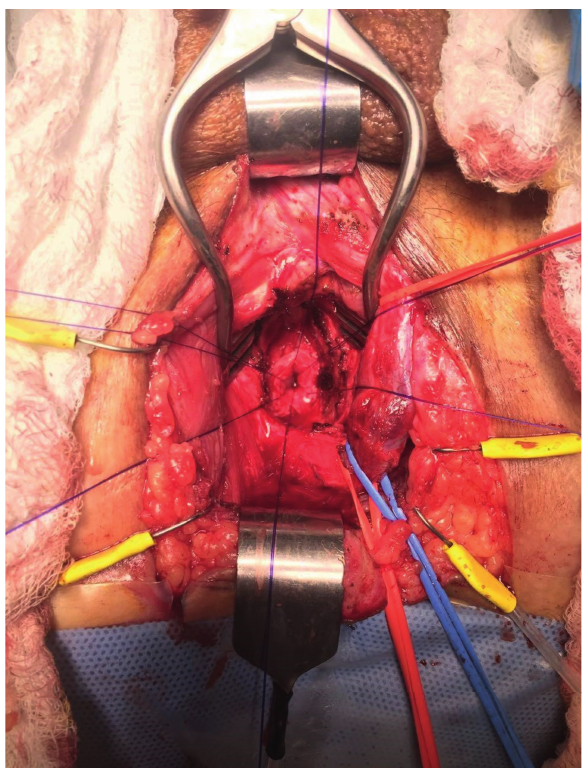
Figure 1 - Urethral lumen previous to re anastomosis by perineal approach. Note that the bulb was not transected so proximal irrigation is